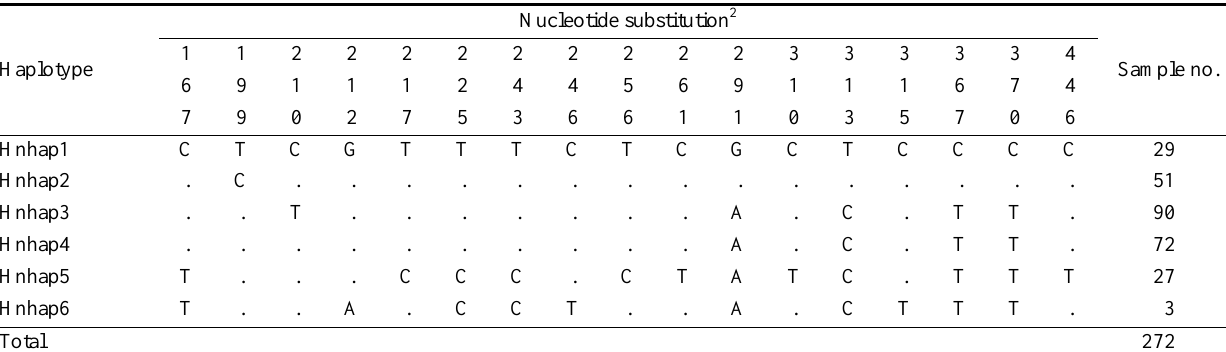
Nucleotide substitution 2